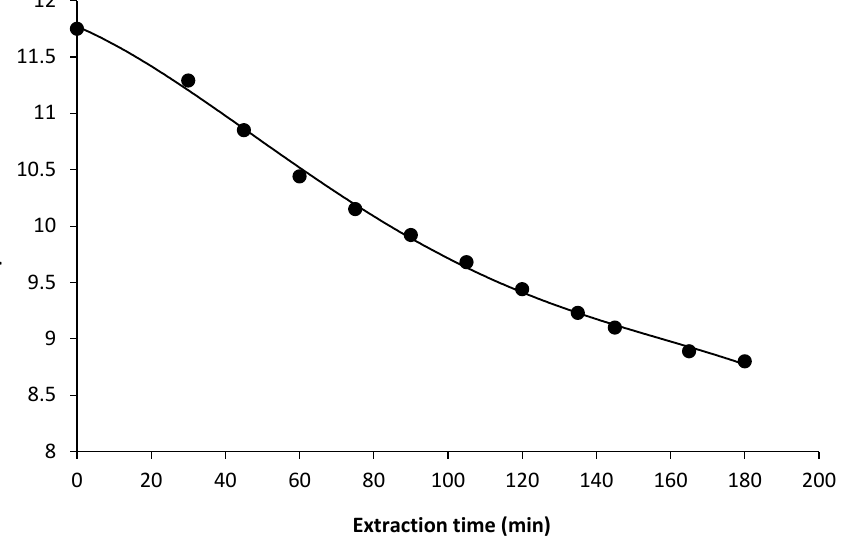
Figure 1. Changes in pH-value of the extraction slurry as a function of the extraction time.